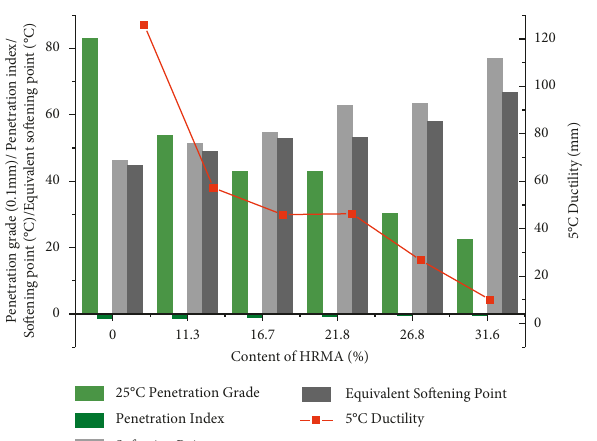
Figure 8: Variation of basic properties of modified asphalt with HRMA content.